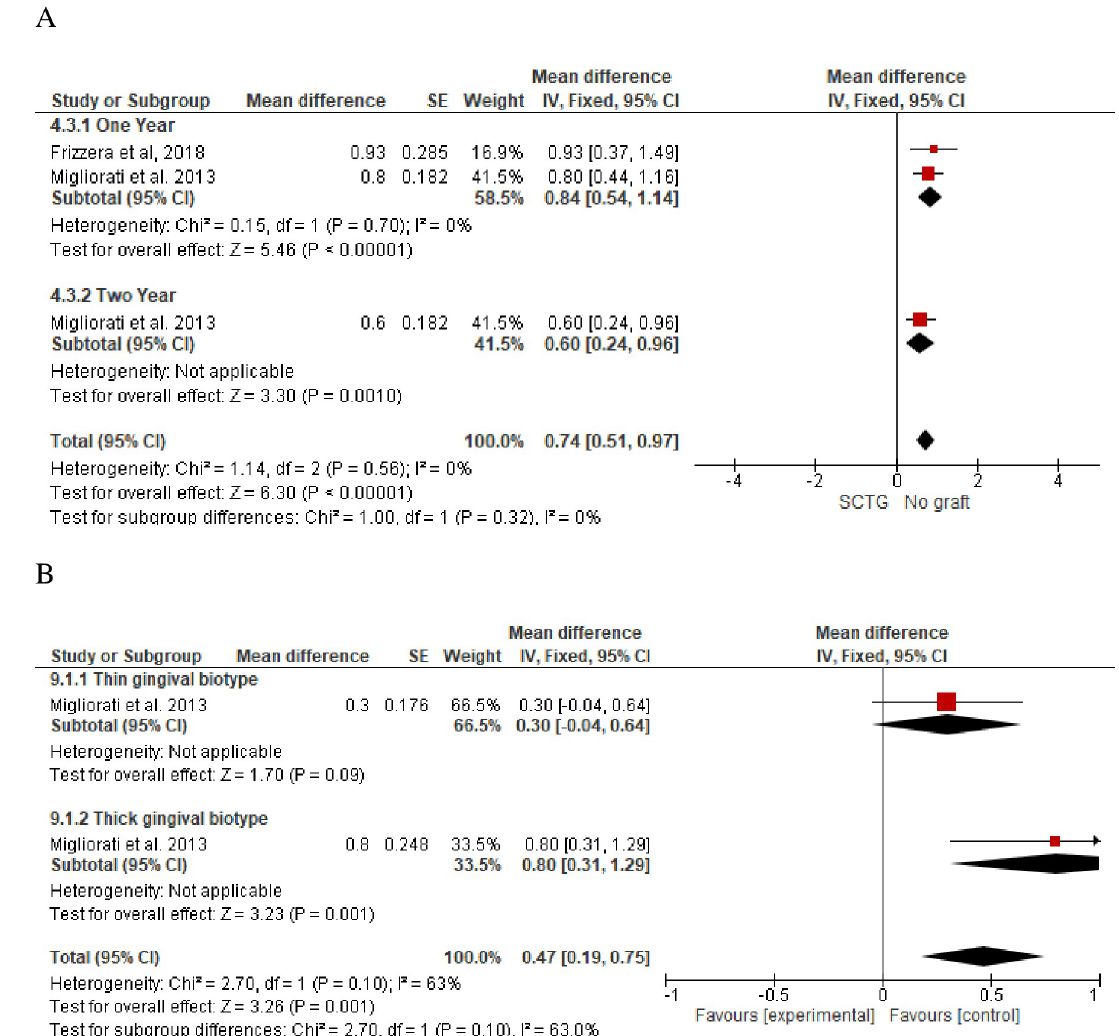
Fig 4. Buccal tissue thickness, SCTG vs no graft along with IIP. A) A subgroup meta-analysis with one- and two-years follow-up. B) A subgroup meta-analysis with thin or thick gingival